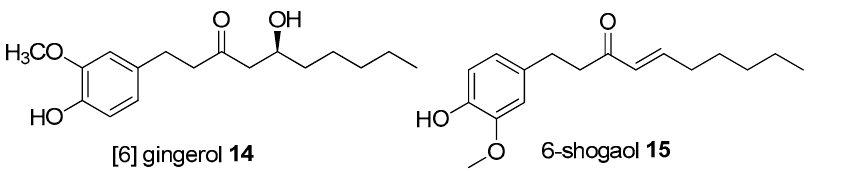
Figure 6. Analgesic compounds of medicinal plants used by Tenggerese (isolated from same species found in other